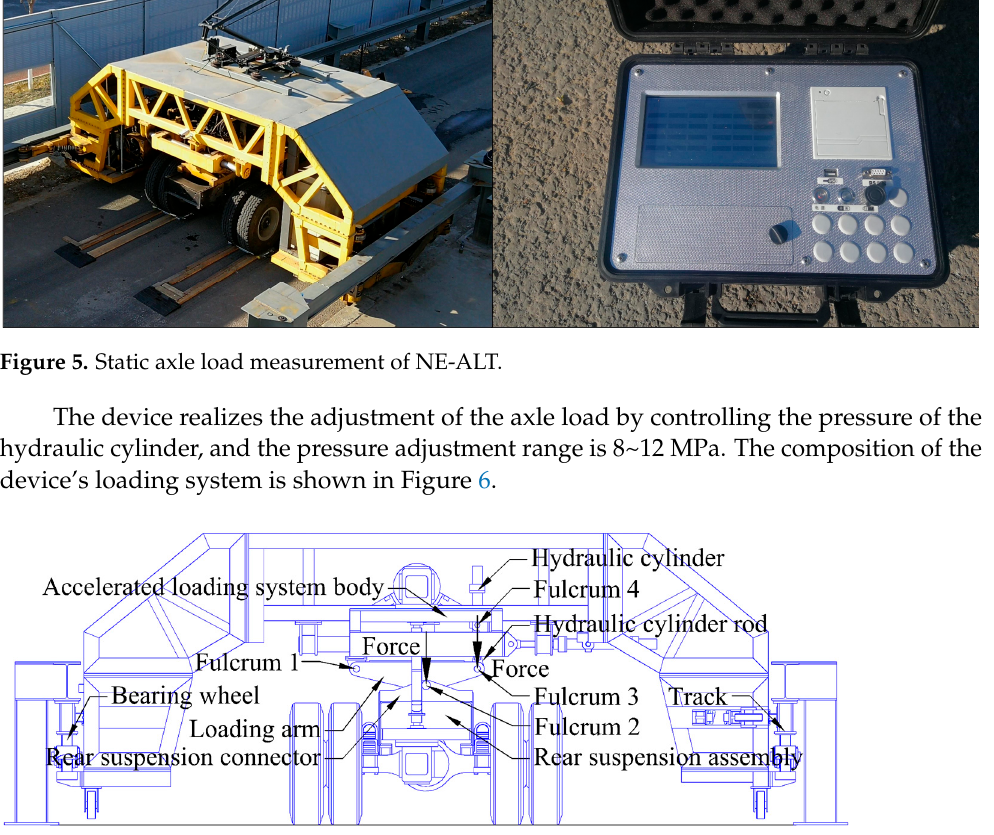
Figure 6. Loading System of NE-ALT.